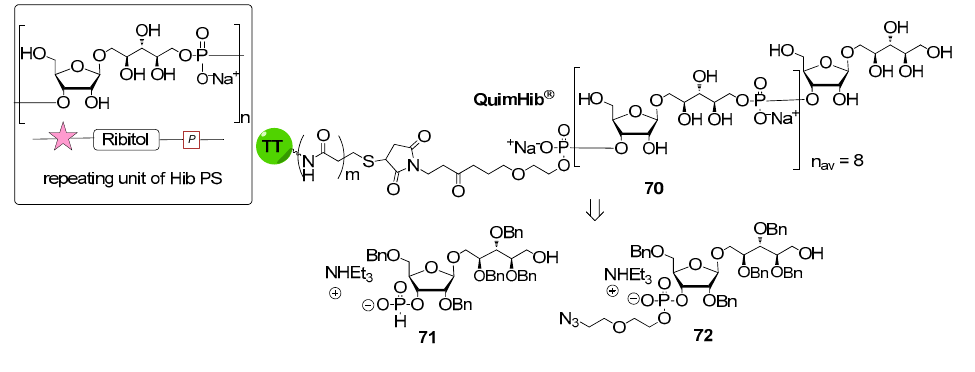
Figure 8. Synthesis of QuimiHib.